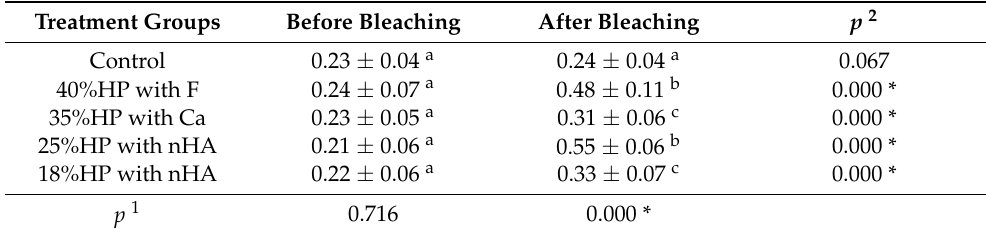
Table 3. Comparison of the mean and standard deviation values of surface roughness for the treatment groups before and after